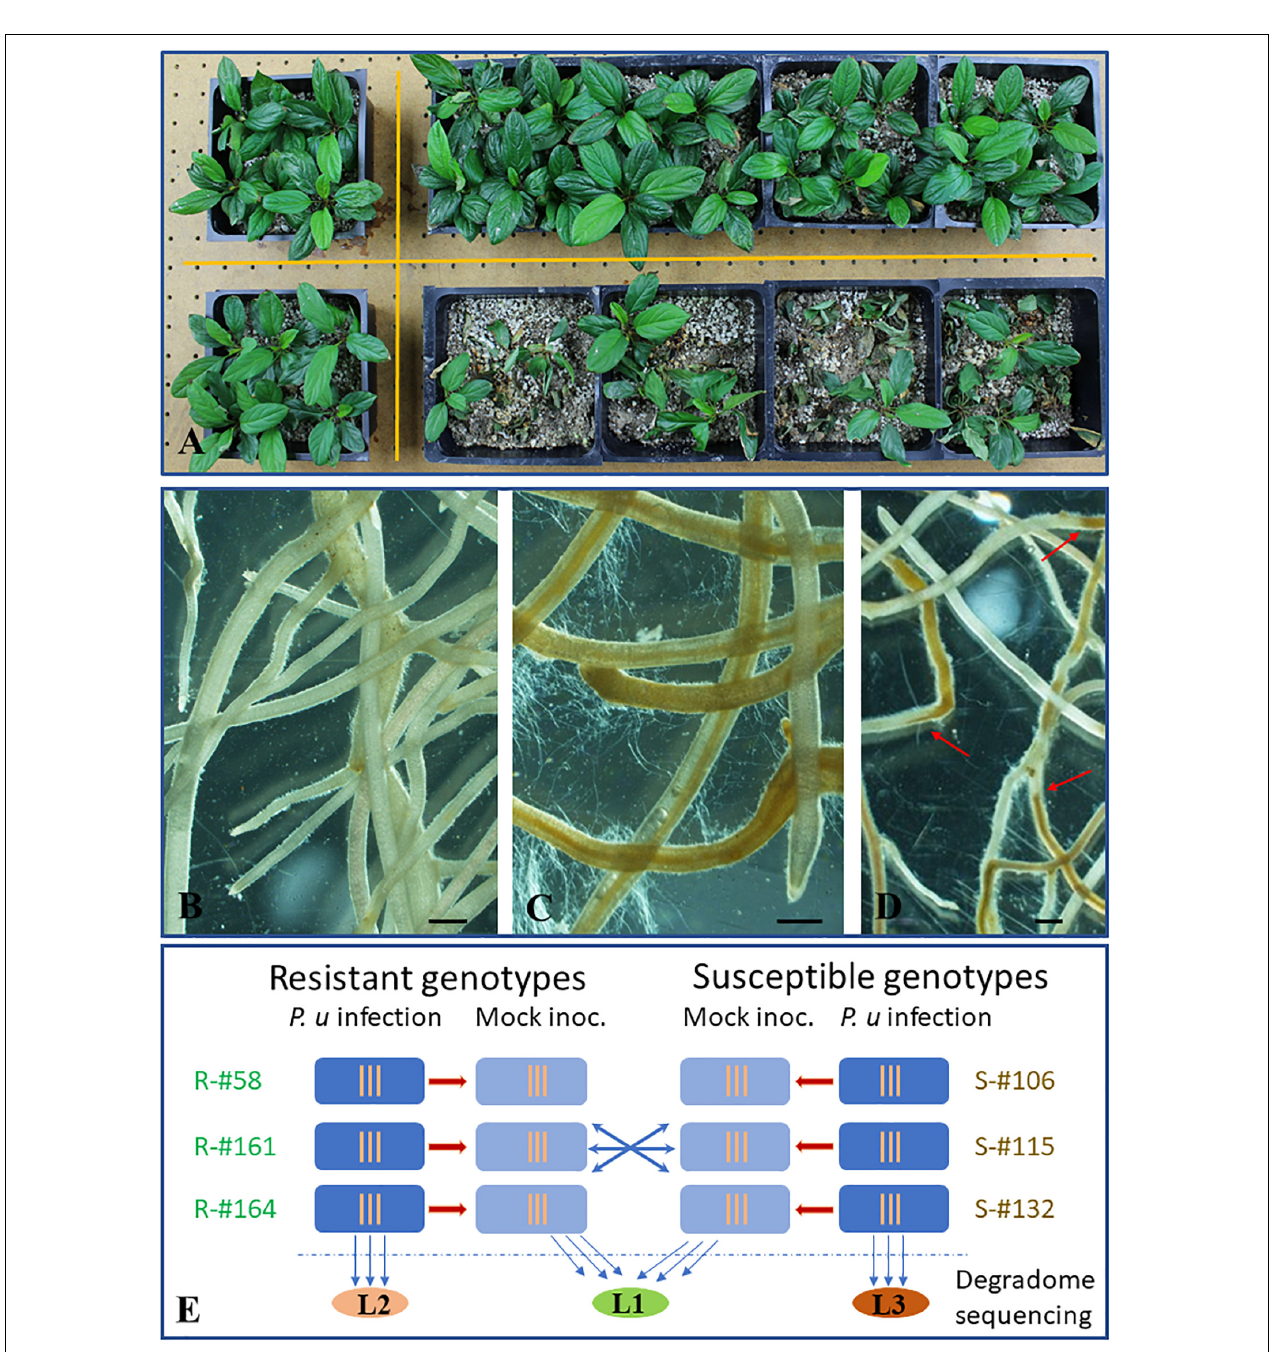
FIGURE 1 | Resistance phenotypes of apple rootstock in response to infection from Pythium ultimum and the experimental design for miRNA profiling and target gene identification. (A) Plant survival rates between a resistant (top, R-#58) and a susceptible (bottom, S-#106) genotype which were simultaneously inoculated with the same preparation of pathogen inoculum. Plants in the left column were the mock-inoculated control for each genotype. (B) Representing image of a mock-inoculated apple root system at 48 hpi; (C) Representing image of apple root branches of a susceptible rootstock genotype (S-#132) inoculated with P. ultimum at 48 hpi, showing profuse hyphae growth and widespread tissue necrosis and collapses. (D) A representing image of apple root branches for a susceptible rootstock genotype (R-#161) inoculated with P. ultimum at 48 hpi, showing abrupt necrosis arrest, with distinct lines separating healthy and necrotic sections along infected roots. Bars represent 300 µ m. (E) Experimental design for microRNA profiling analysis and degradome sequencing. Root tissues at 48 hpi from three resistant (R-#58, -#161, and -#164) and susceptible genotypes (S-#106, -#115, and -#132) were used for small RNA library construction and subsequent high-throughput sequencing. Normalized read counts were compared within and between genotypes. Three vertical lines indicate three biological replicates for each sample (specific genotype/treatment combination). Three colored oval shapes represent three pooled samples for degradome libraries and sequencing analysis, where L1 stands for combined mock-inoculated root tissues (from both resistant and susceptible genotypes), L2 for combined root tissues consisting of infected resistant genotypes, and L3 for combined root tissues consisting of infected susceptible genotypes. Red arrows indicate the defined lines separating healthy and necrotic